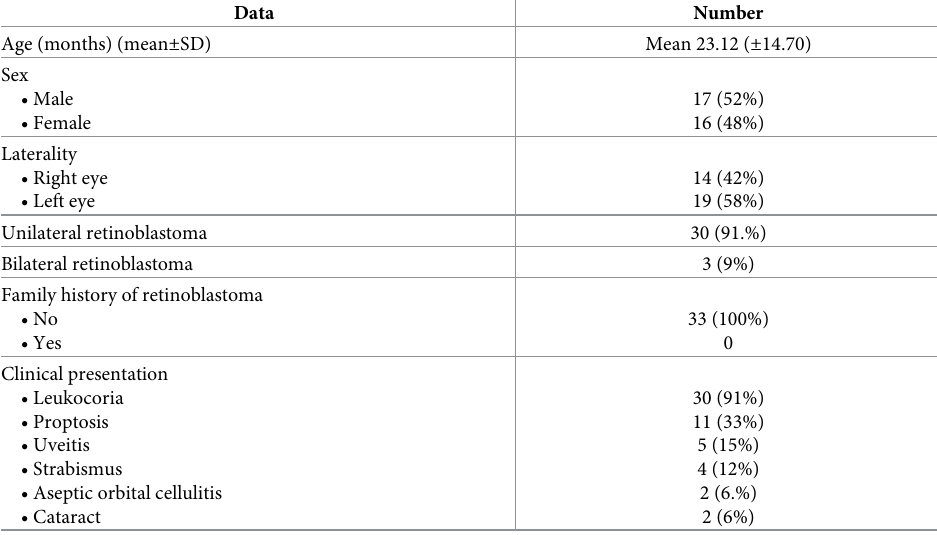
Table 2. Demographic data and clinical presentation of primary enucleated retinoblastoma